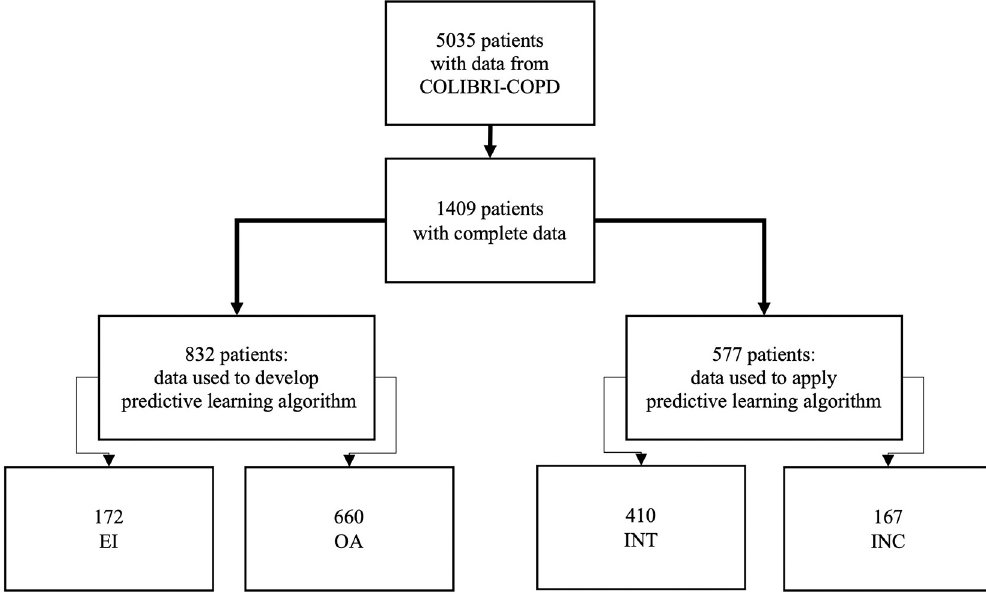
Fig 1. Study design. See Table 1 for definitions of activity